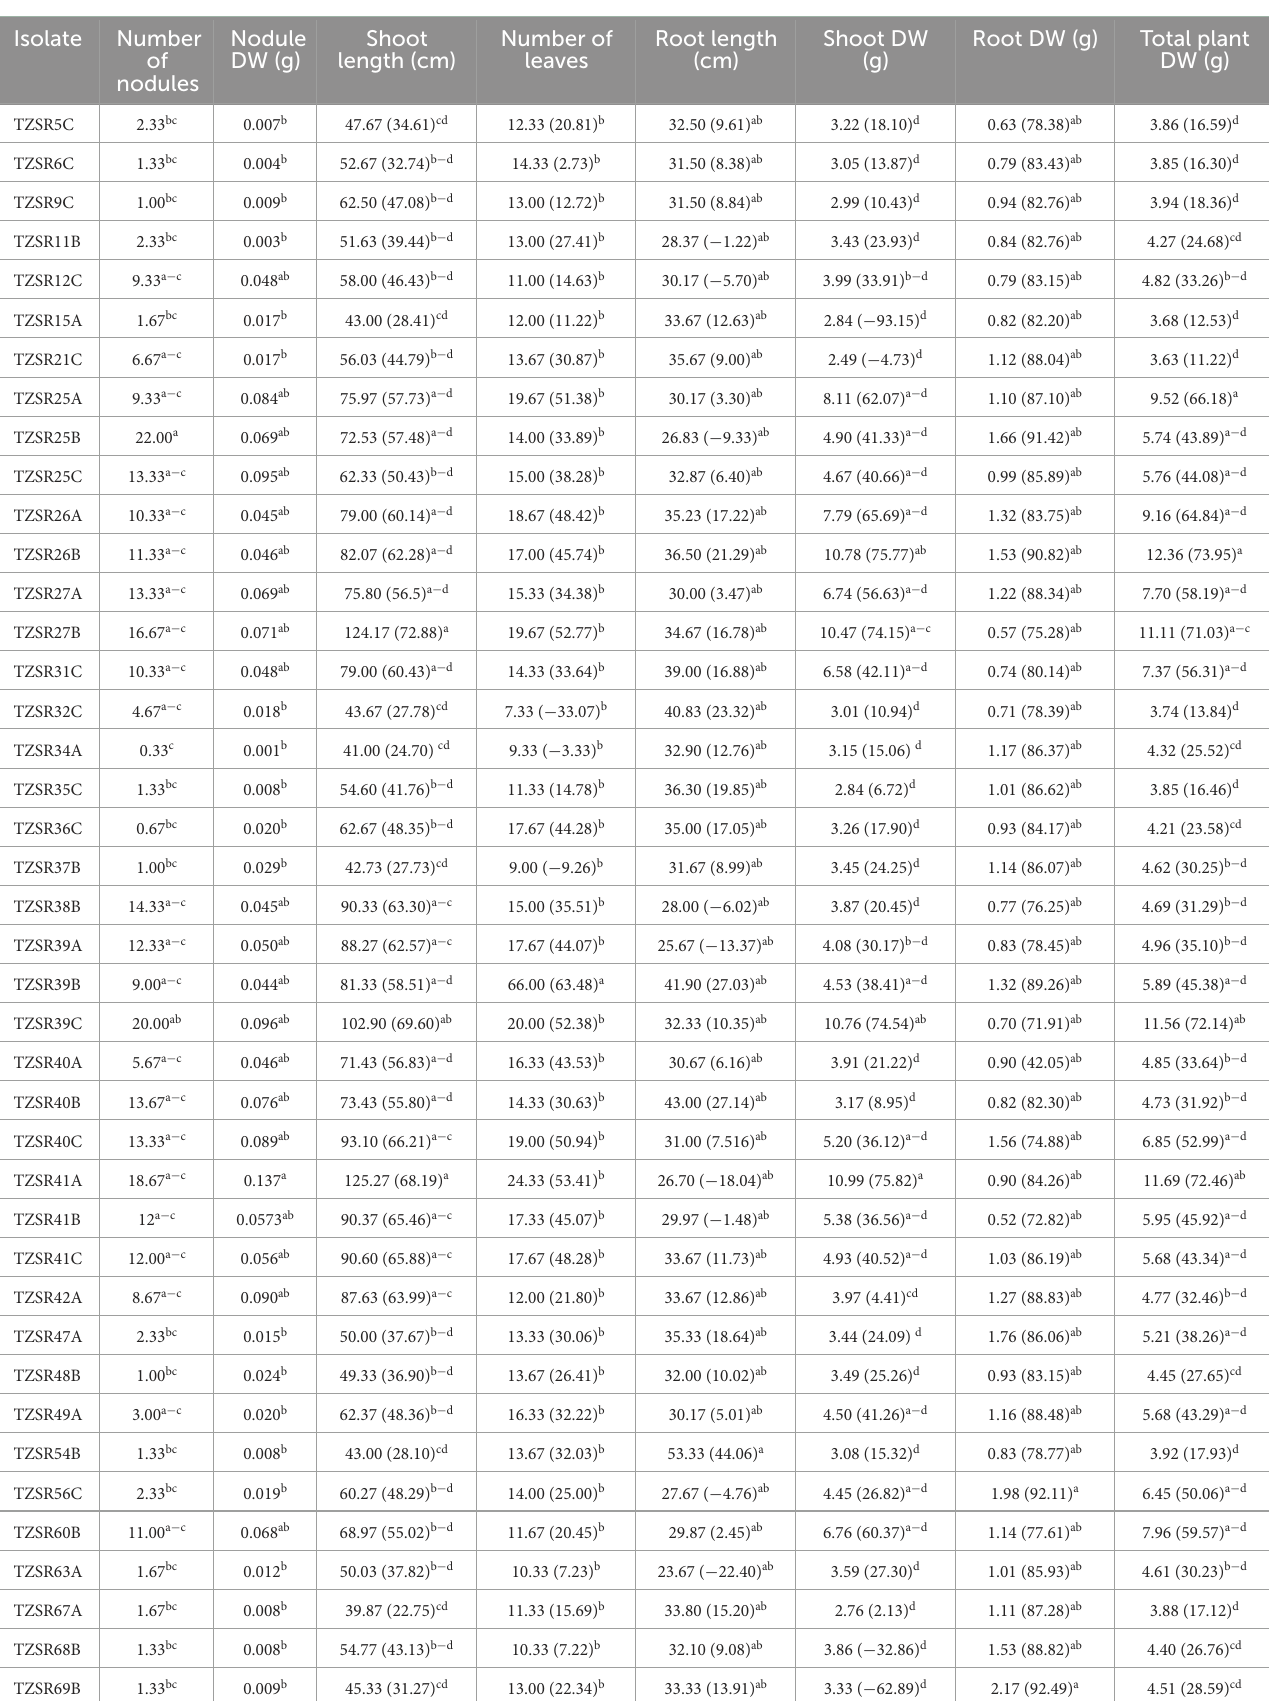
TABLE 2 Growth and yield components of soybean as affected by inoculation with rhizobia isolates. Isolate Number